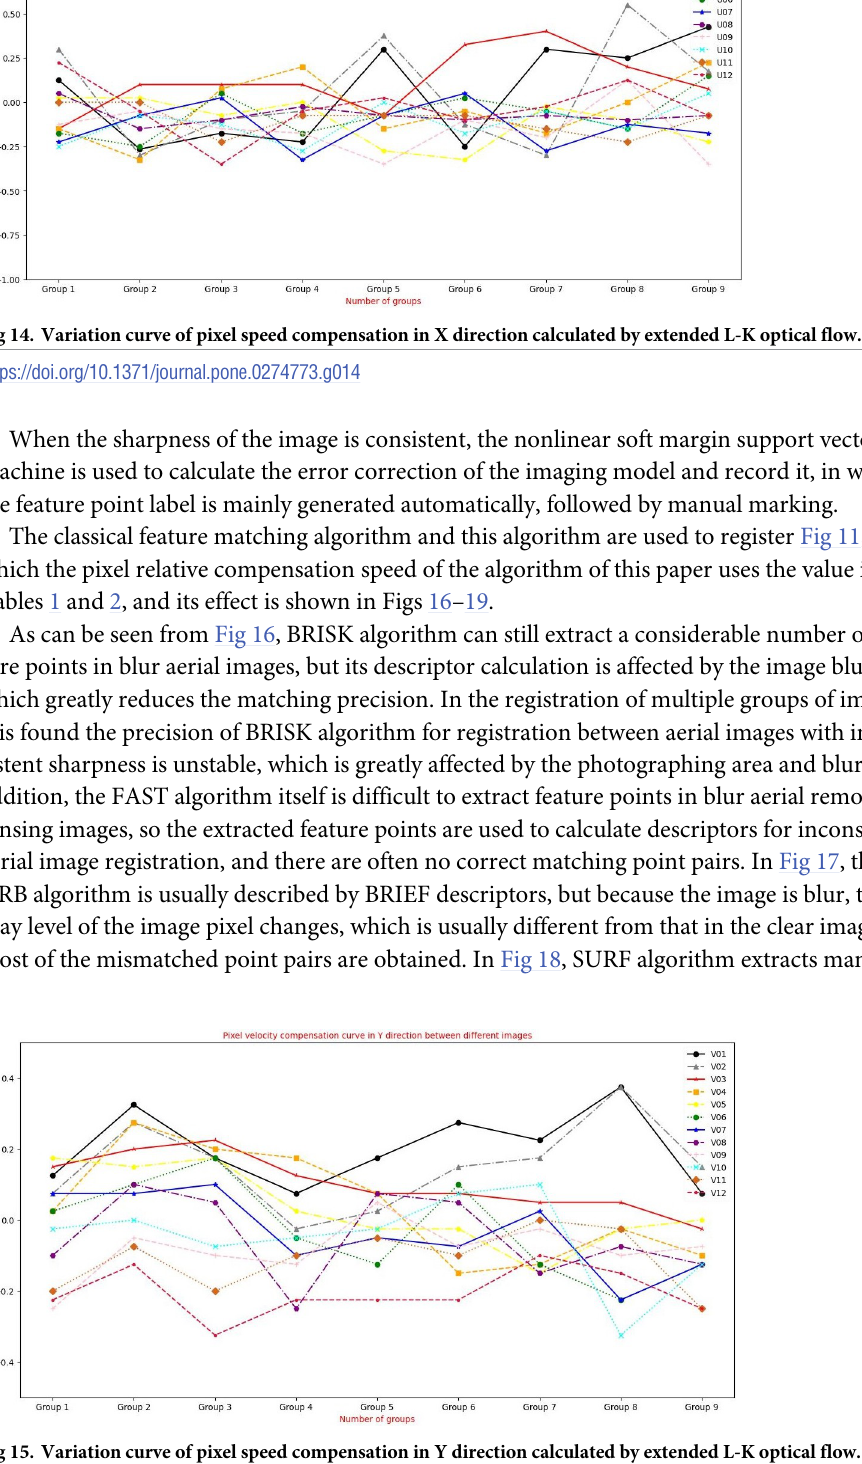
Fig 15. Variation curve of pixel speed compensation in Y direction calculated by extended L-K optical